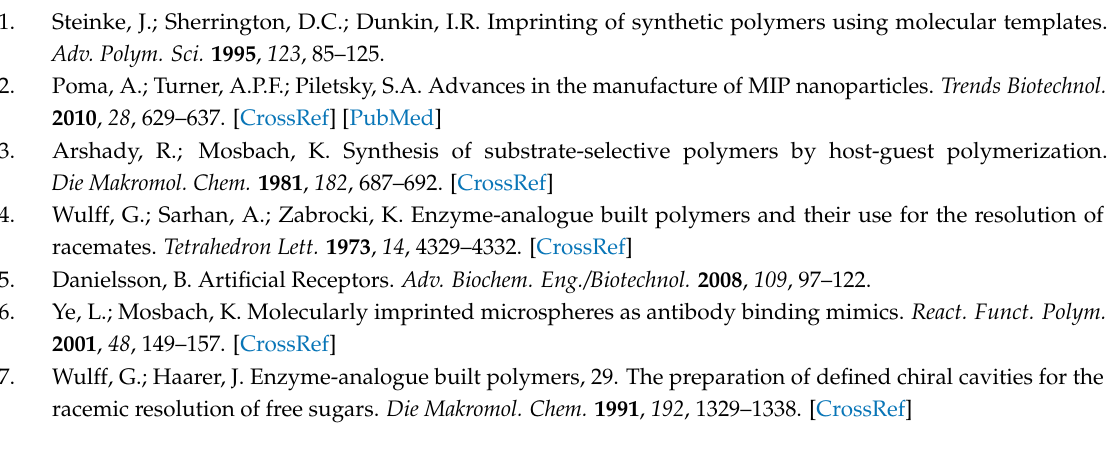
Supplementary Materials: Supplementary Materials are available online. Table S1: Summary of imprinting results, Table S2: Polymer feed compositions, Figure S1: SEM images of microspheres from various T:fM ratios, Figure S2: Particle sizes of microspheres from various T:fM ratios, Figure S3: Incorporation of CAF and THP in polymers from various T:fM ratios, Figure S4: Incorporation of CAF and THP in polymers from various fM:X ratios, Figure S5: CAF incorporation and rebinding by MIPs and NIPs from various fM:X ratios, Figure S6: THP incorporation and rebinding by MIPs and NIPs from various fM:X ratios, Figure S7: SEM images of microspheres from various I:tM ratios, Figure S8: CAF and THP incorporation in polymers from various I:tM ratios, Figure S9: An example of a 1H NMR spectrum of the caffeine pre-polymerization